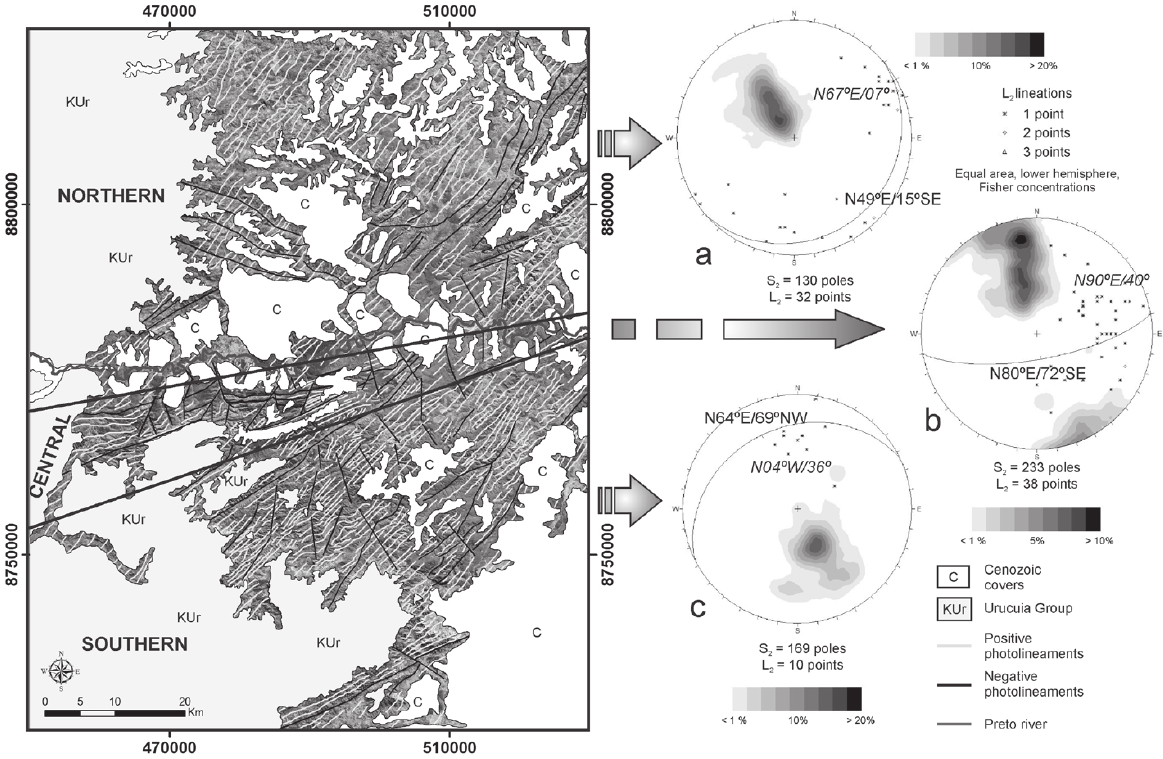
Figure 3 - Photolineament map and structural compartmentation of the Rio Preto fold belt, with isoareal contour stereograms for the poles of S and scattered points for L for a) Northern, b) Central and c) Southern Compartment. The attitudes in each 2 2 stereogram represent the modal maximum for S and L (the latter in italics). Positive lineaments correspond to positive relief in 2 2 the field, often coincident with bedding or metamorphic foliation, while negative lineaments correspond to negative relief, often coincident with fractures, faults or shear